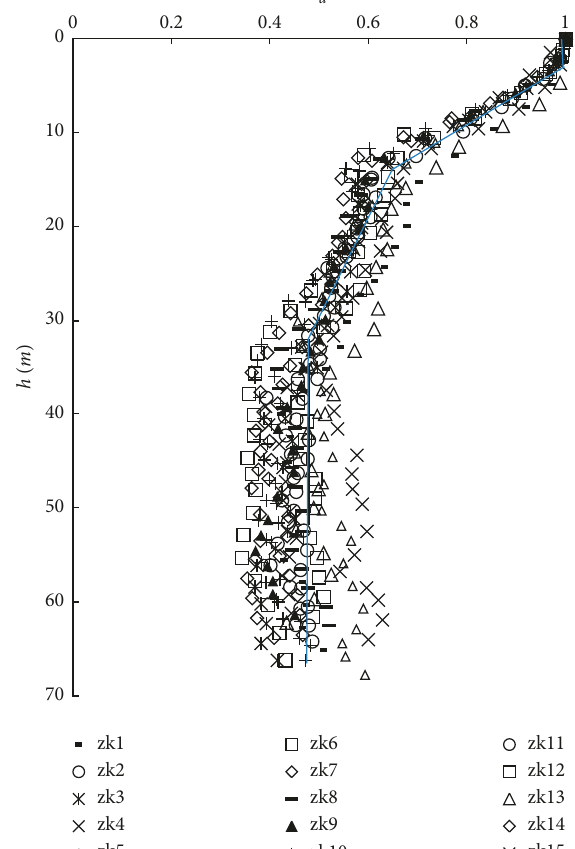
Figure 12: Shear stress reduction versus depth for loess